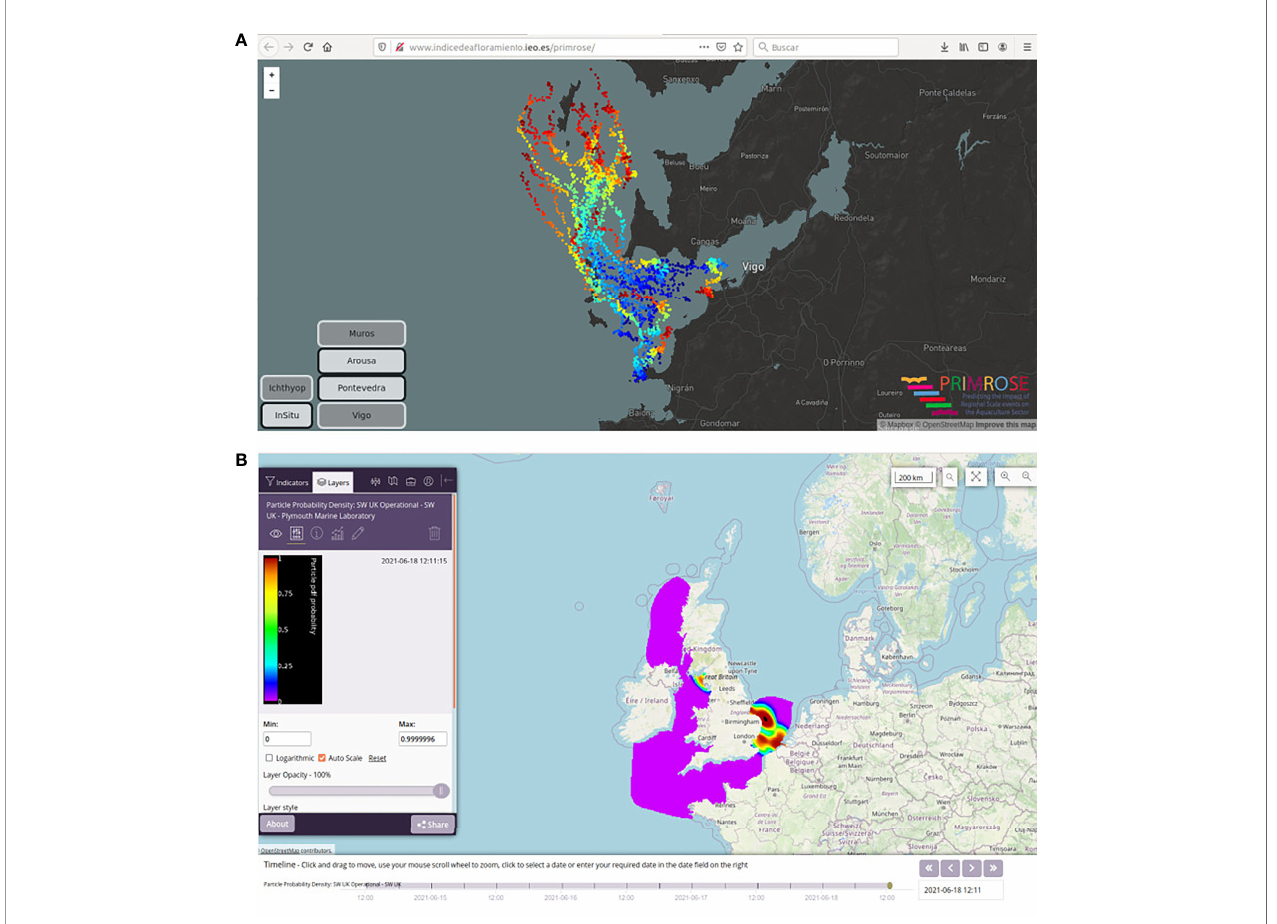
FIGURE 12 | Presentation of Lagrangian particle tracking operational results demonstrated during the PRIMROSE project. (A) Lagrangian particle forecast for R ı ́ a de Vigo corresponding to 29th September 2020 run as served by the IEO data viewer (http://www.indicedea fl oramiento.ieo.es/primrose), also available at the PRIMROSE portal (https://primrose.eofrom.space/?state=ae63b8). Time is represented in the plot as colour for the particle positions, from blue at the start through to red three days after. (B) Lagrangian particle forecast from PML model corresponding to 18th June 2021 as served by the PRIMROSE portal (http://primrose. eofrom.space). The probability density fi eld shows the probability of a bloom incurring on a particular location at a particular time step, considering both the probability of an accurate identi fi cation from the remote sensing algorithm and from the uncertainty in the predicted particle